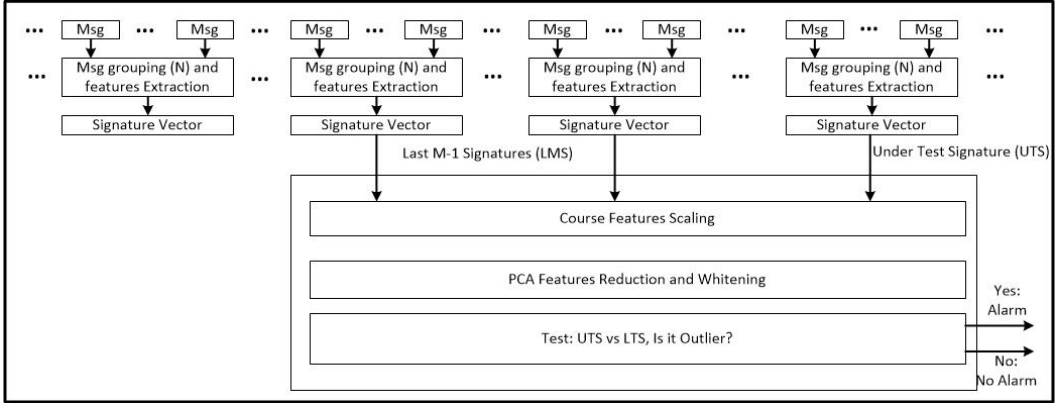
Figure 4. ADS-B signal features extraction block